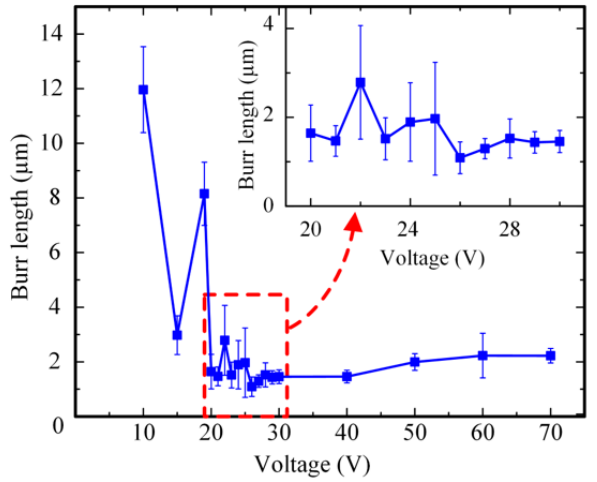
Figure 7. Influence of machining voltage on the average length of the hole mouth burr.